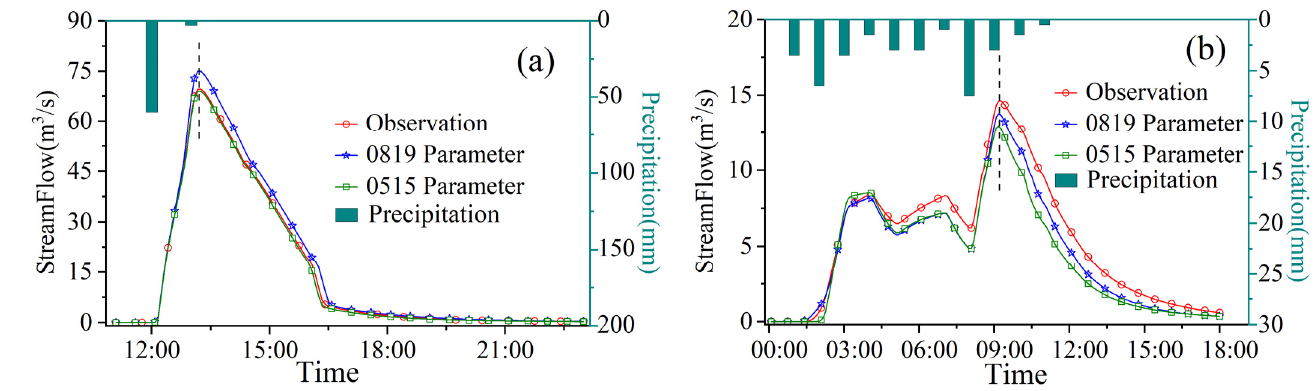
Figure 8. Flow simulation results using two sets of parameter during the validation period: ( a ) Rain- fall event 0801; ( b ) Rainfall event